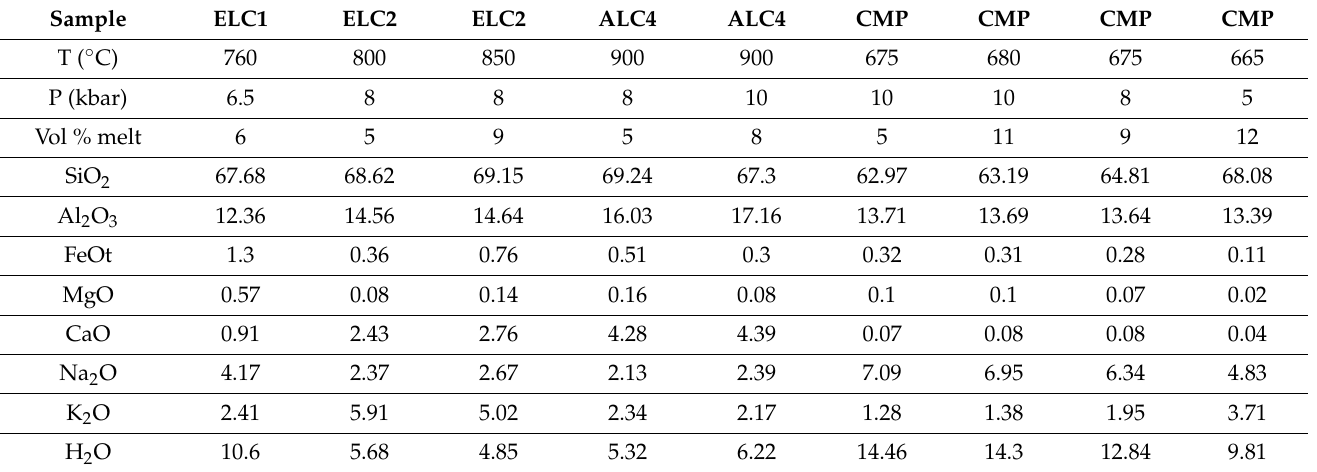
Table 6. P-T conditions, partial melting degrees and major elements compositions for Perple_X computed